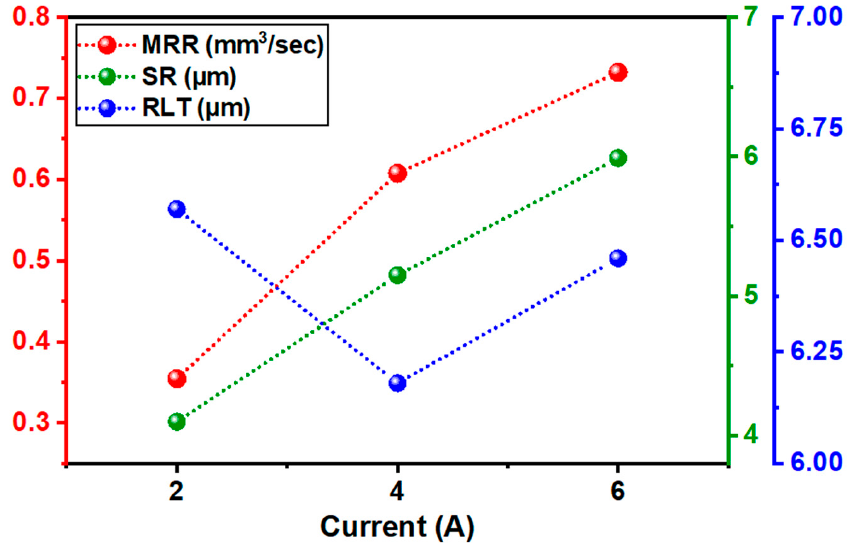
Figure 5. Effect of current on MRR, SR, and